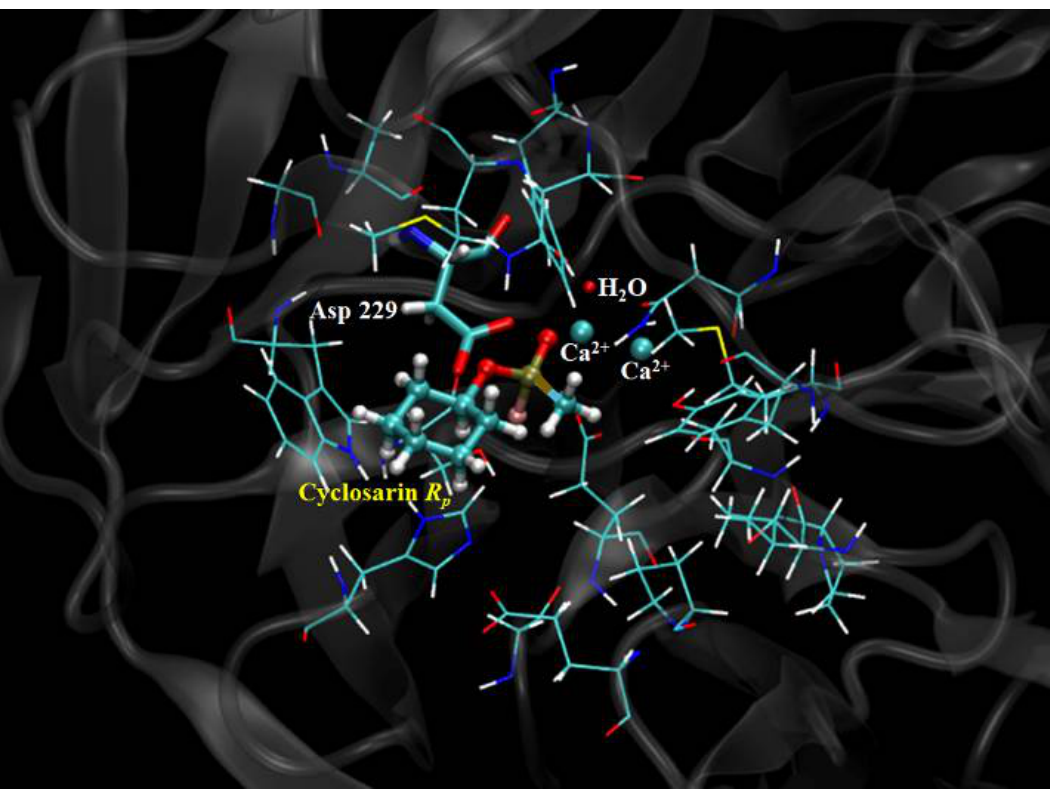
Figure 12. QM reactional system (highlighted in coloured atoms) for the Cyclosarin ( R P enantiomer) degradation by DFPase, considering a radius of 5 Å. All coloured residues were taken into account for the QM reactional system.